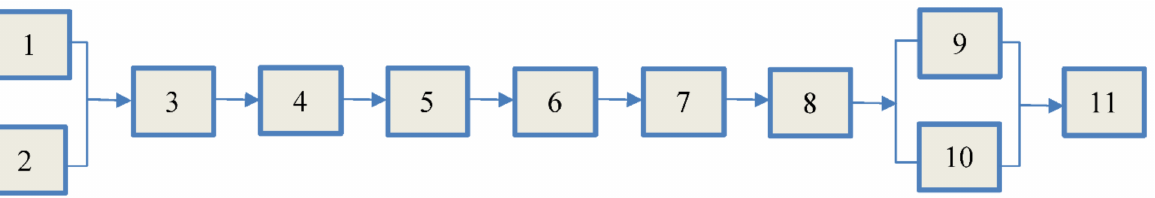
Figure 8. Project network plan for a concrete-face rockfill dam. Legend: 1—left-bank slope excavation; 2—right-bank slope excavation; 3—riverbed excavation; 4—consolidation grouting; 5—curtain grouting; 6—anti-seepage wall construction; 7—dam-body filling; 8—panel pouring; 9—wave-break wall construction; 10—dam-crest construction; 11—tail processing, data sorting and